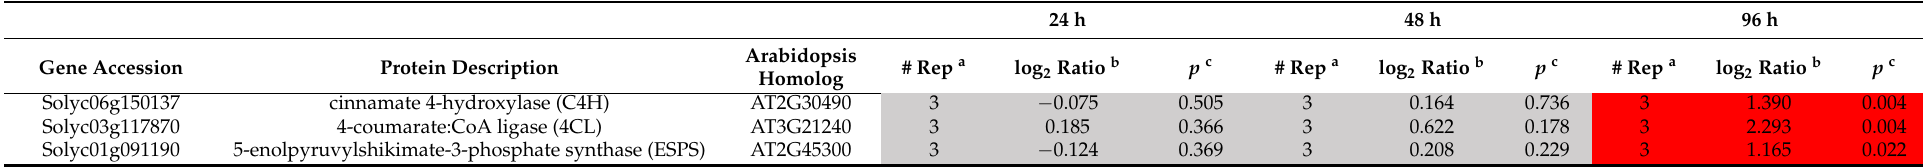
Table 7. Proteins involved in secondary metabolism with a significant change in abundance at 24, 48 and 96 h post-inoculation with P. infestans